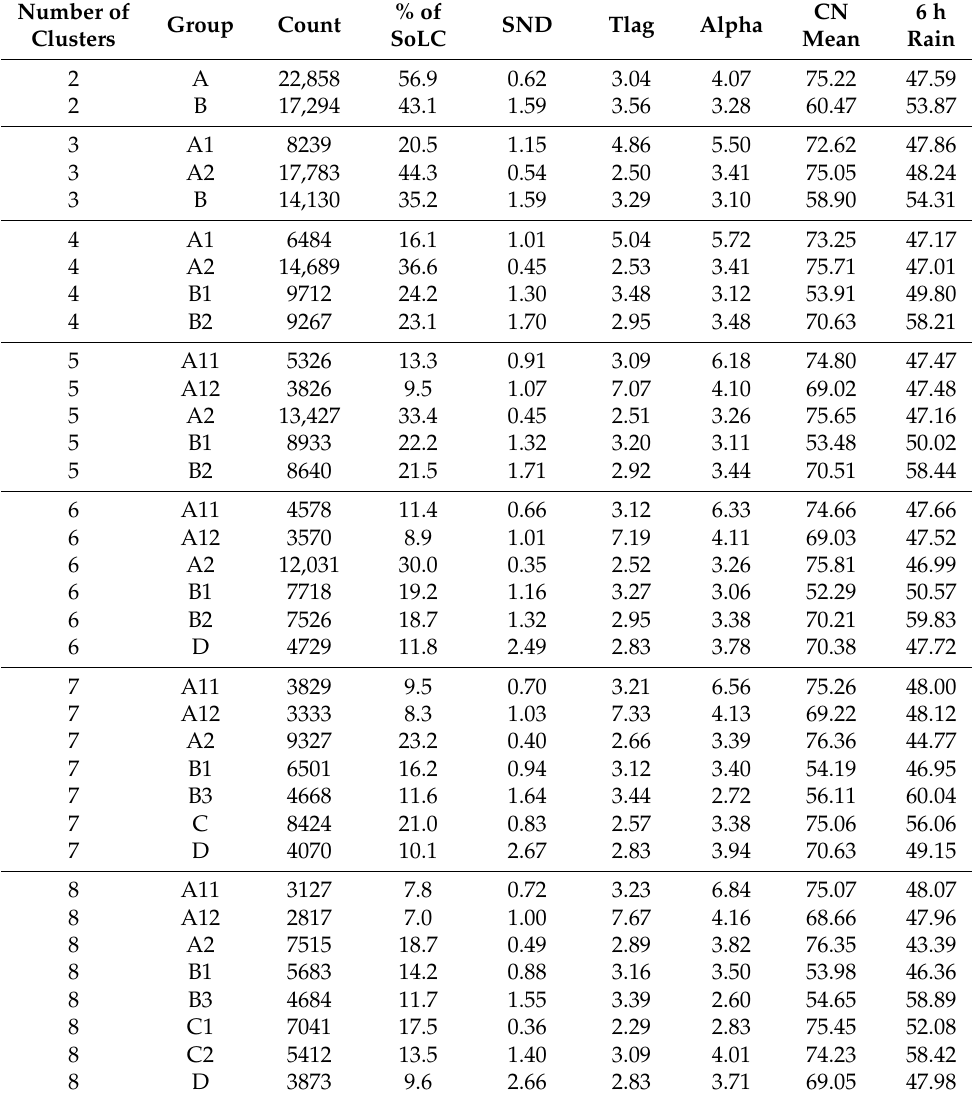
Table A1. A table presenting the development of the parameter values in the cluster centroids during the progressive formation of two to eight clusters. The table also shows the number of elements in the respective in each group (Count) of the total number of SHCs in SoLC, the in SoLC. The value is also expressed as a